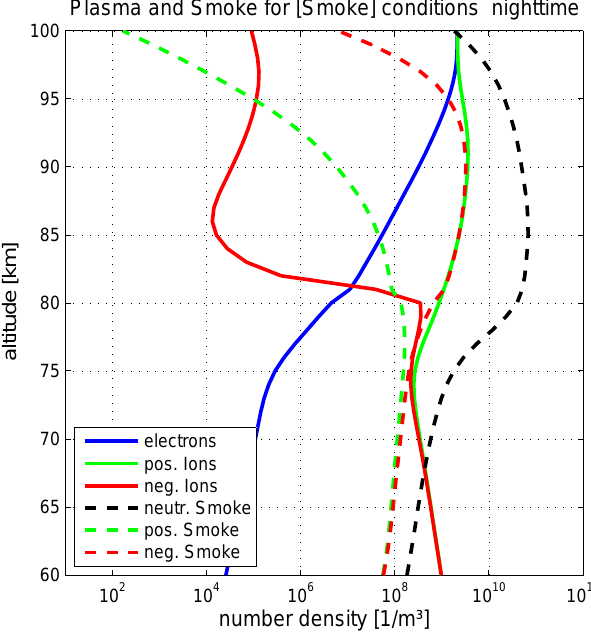
Fig. 6. Height profiles of the six modelled species, electrons, pos- itive ions, negative ions, neutral MSP, positive MSP and negative